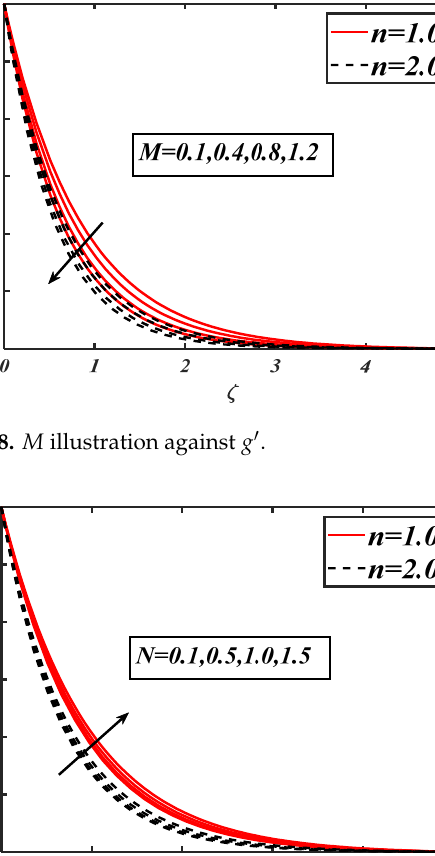
Figure 7. Nc illustration against f